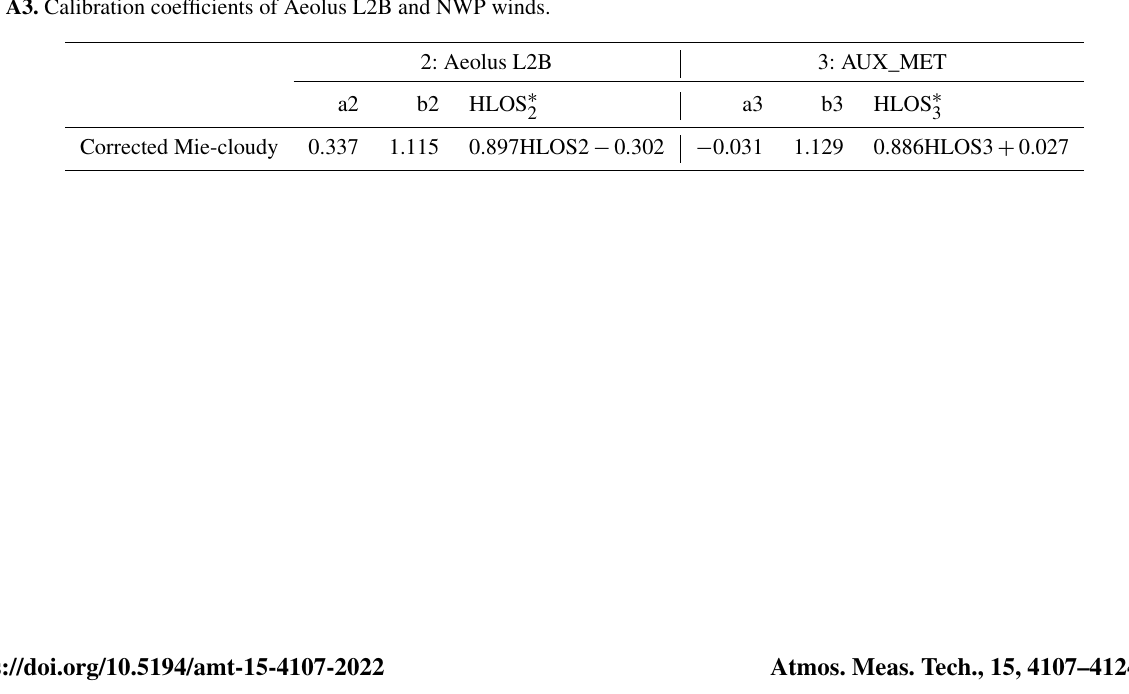
Table A3. Calibration coefficients of Aeolus L2B and NWP